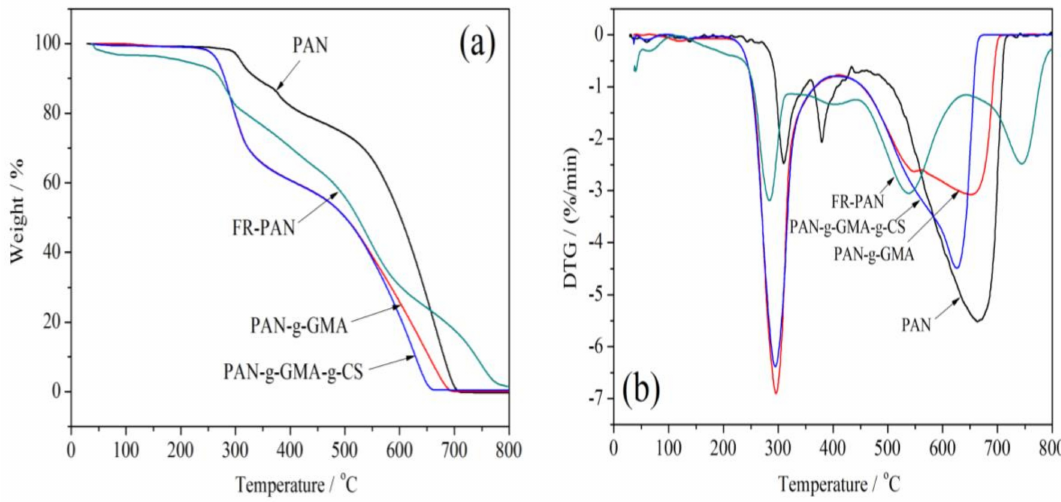
Figure 3. TG ( a ) and DTG ( b ) curves of PAN and modified PAN fabrics.